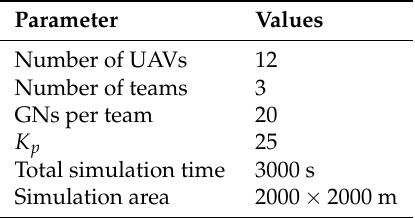
Table 4. Parameters used for testing the frequency and duration of